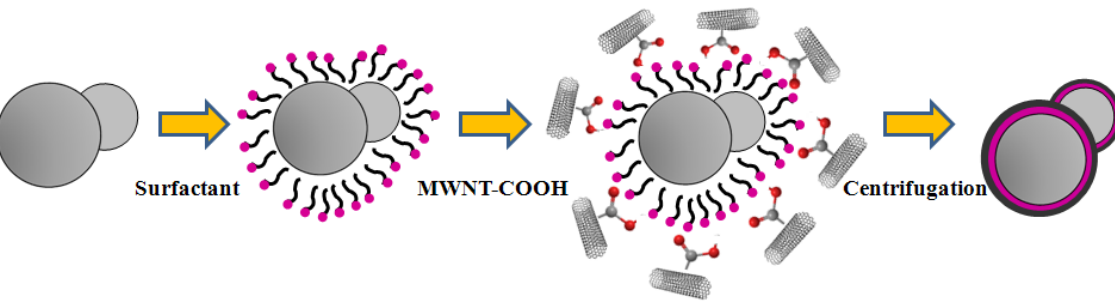
Figure 3. Preparation route for the c-MWNT–SL particles (reprinted with permission from [36], Copyright 2012 The Royal Society of